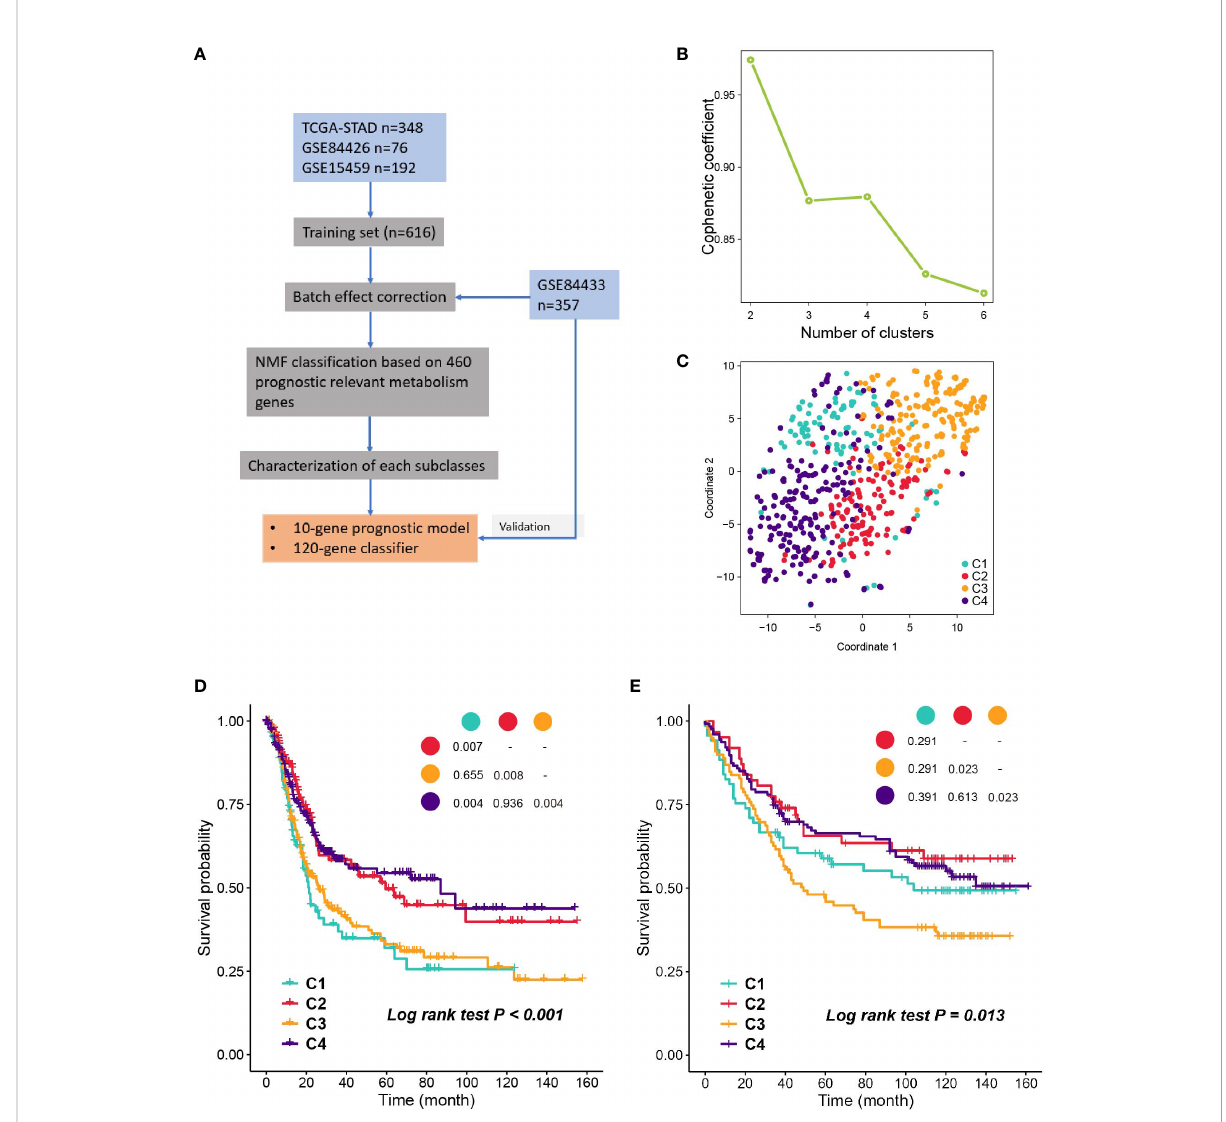
FIGURE 1 Identi fi cation of subclasses with NMF. (A) The fl ow chart of the study. (B) Cophenetic coef fi cient of NMF for k= 2 to 6, k=4 is chosen as the optimal. (C) Visualization of the clustering result in the training set with t-SNE. (D, E) Kaplan- Meier plot of OS of subclasses in training set and validation